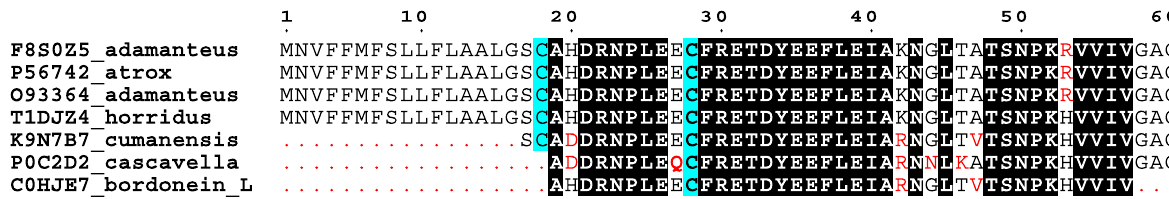
Fig. 3 Multiple sequential alignment of snake venom L-amino acid oxidases from the genus Crotalus . Initial N-terminal of bordonein-L [Swiss-Prot: C0HJE7, bottom] and LAAOs from crotalic venoms: C. adamanteus [Swiss-Prot: F8S0Z5, O93364], C. atrox [Swiss-Prot: P56742], C. horridus [Swiss-Prot: T1DJZ4], C. d. cumanensis [Swiss-Prot: K9N7B7 – fragment] and C. d. cascavella [Swiss-Prot: P0C2D2 – fragment]. The highly conserved residues in bordonein-L are highlighted in black. The amino acid residues in red indicate low consensus. Cys residues are shaded in blue. The alignment and figure were generated by the servers MultAlin [52] and ESPript [53], respectively